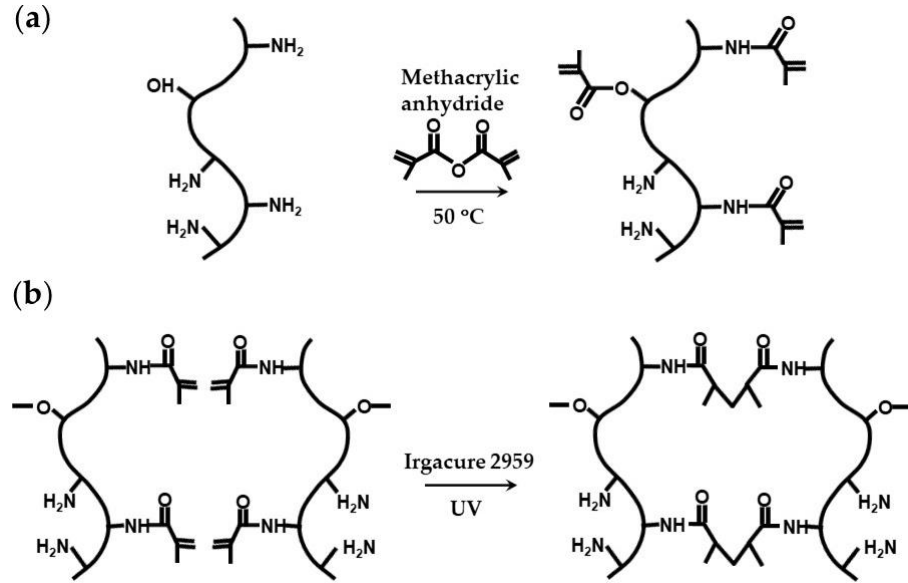
Figure 25. Synthesis and photocrosslinking of gelatin methacryloyl (GelMA): ( a ) Conjugation of